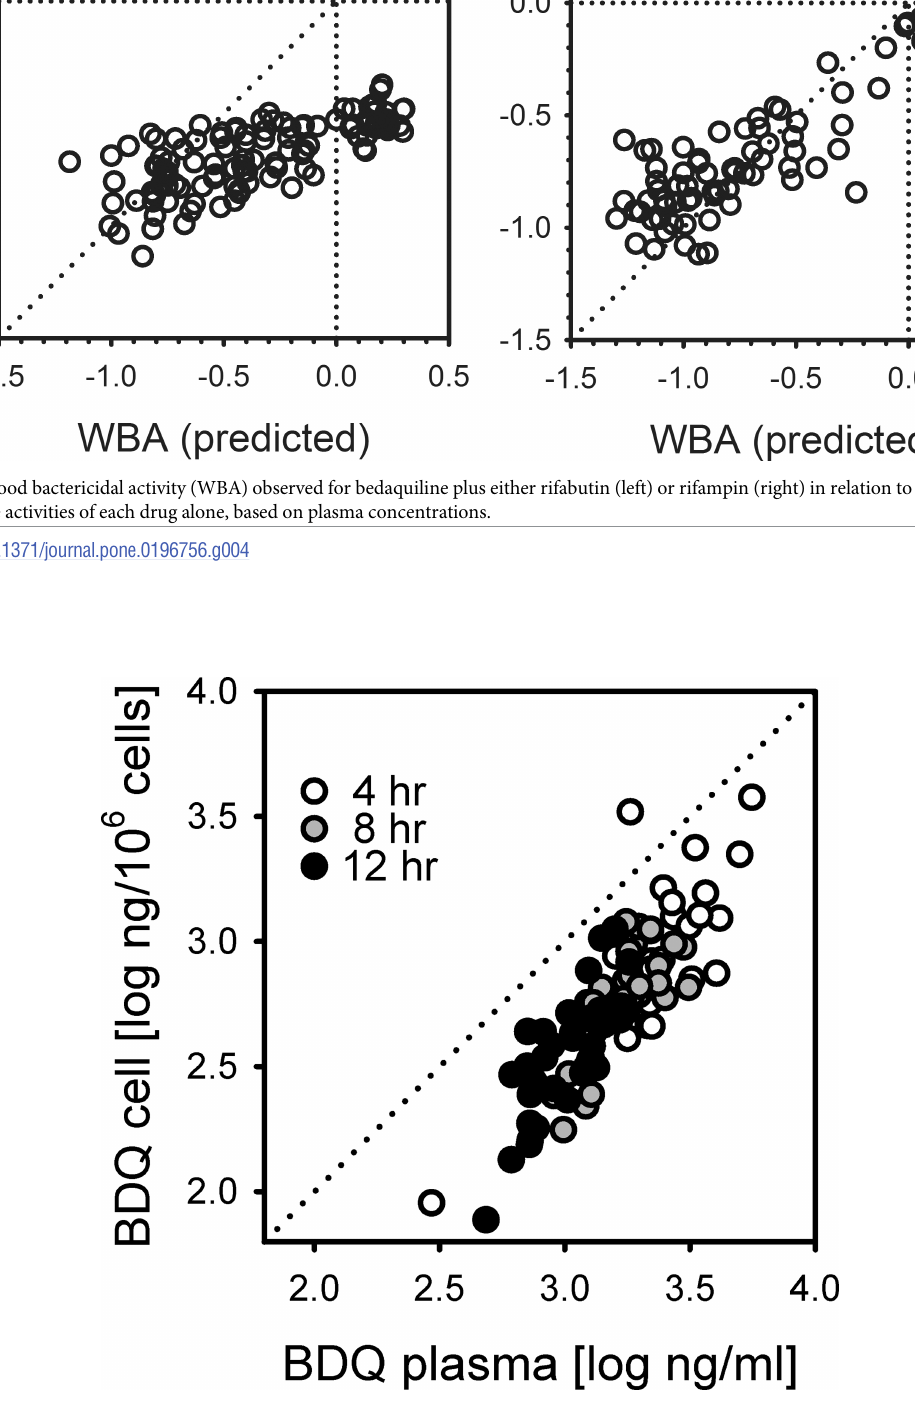
PLOS ONE | https://doi.org/10.1371/journal.pone.0196756 May 2,